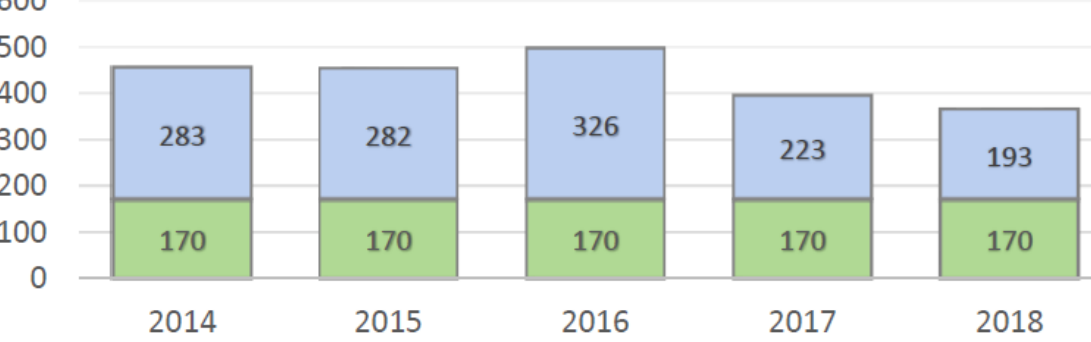
Figure 3: Payment of profit share and transfer to retained earnings account of METROSTAV (CZK million), (source: Annual report of METROSTAV 2014-2018, data processed by the authors) In contrast to other large construction companies, which are controlled from abroad, METROSTAV approaches the payment of dividends with caution and keeps most of the profits in the company, which documents the growth of the retained earnings account - Figure